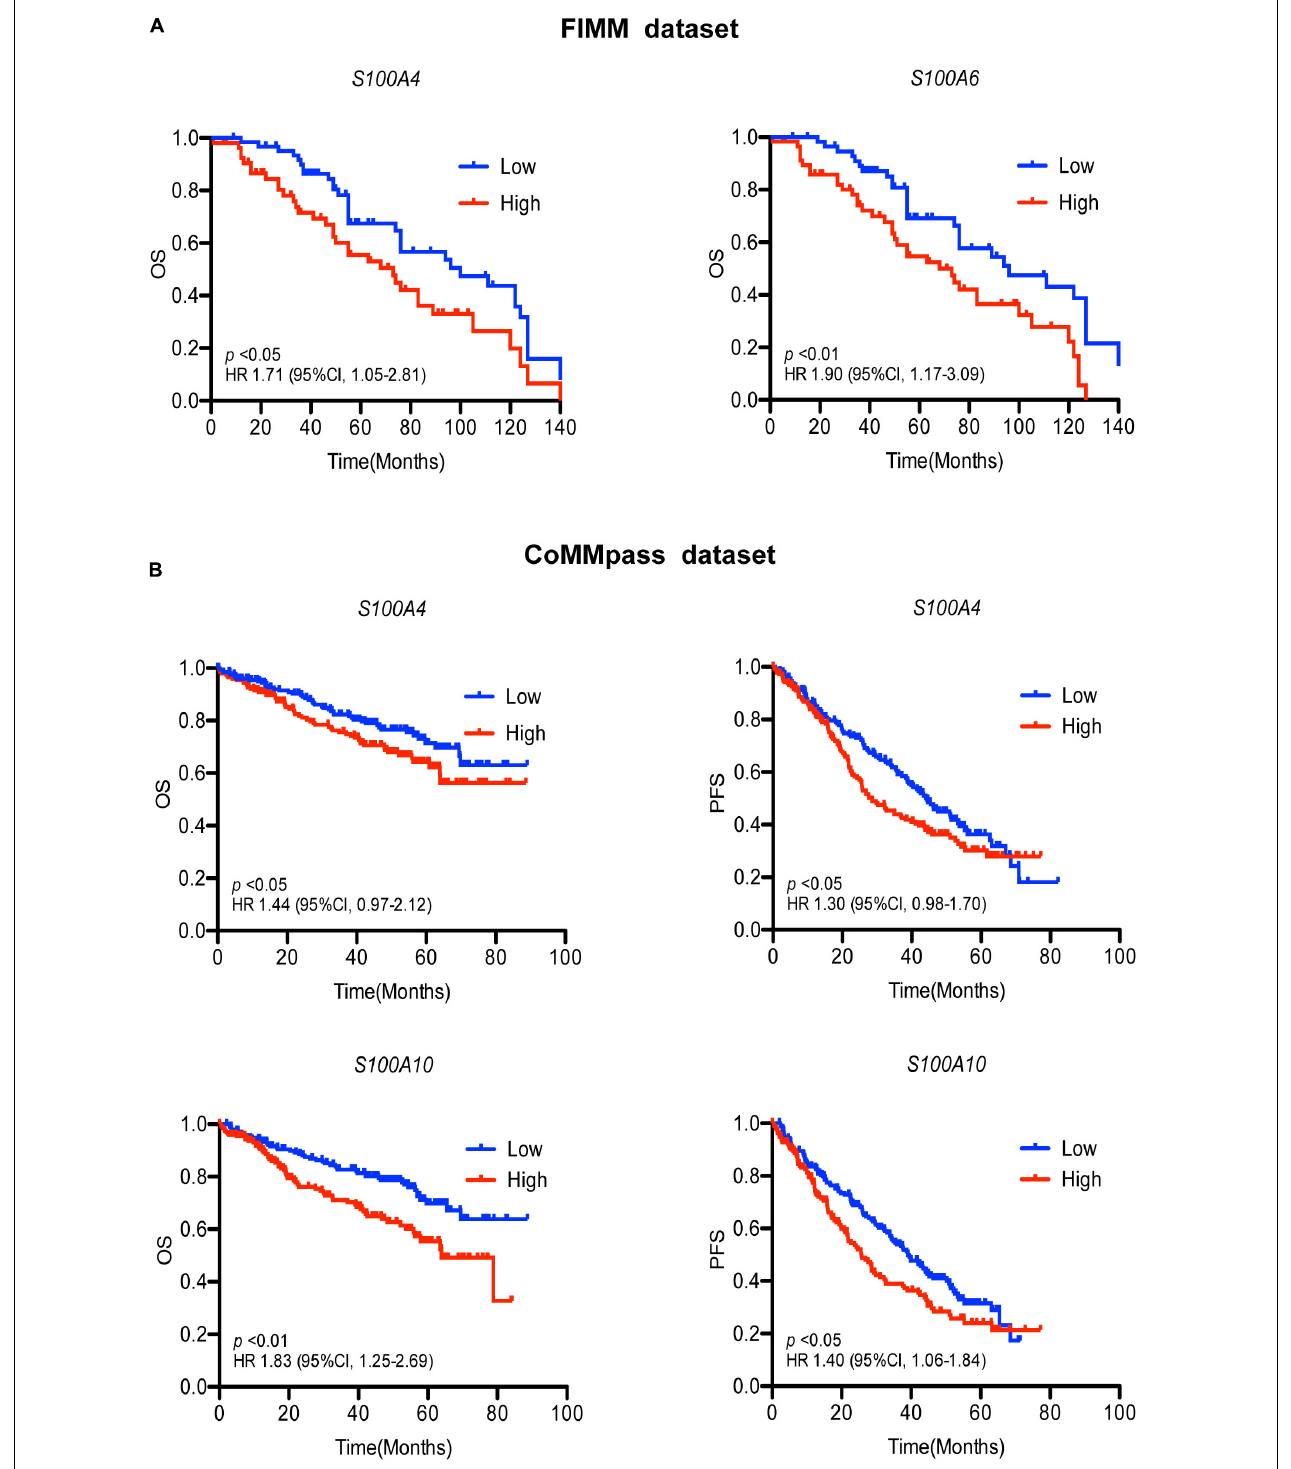
FIGURE 3 | Association of S100 gene expression with patient prognosis. (A) High expression of S100A4 and S100A6 associate with poor prognosis in the FIMM dataset consisting of 116 MM samples. Low and high are defined as expression below and above the median value. (B) Higher expression of S100A4 and S100A10 are associated with shorter OS and PFS in the CoMMpass dataset including 800 MM samples. Patients were divided into groups with expression levels above the 75% percentile (high expression) and below 25% percentile (low expression). OS, overall survival; PFS, progression free survival; HR, hazard ratio; CI, confidence interval; FIMM, Institute for Molecular Medicine